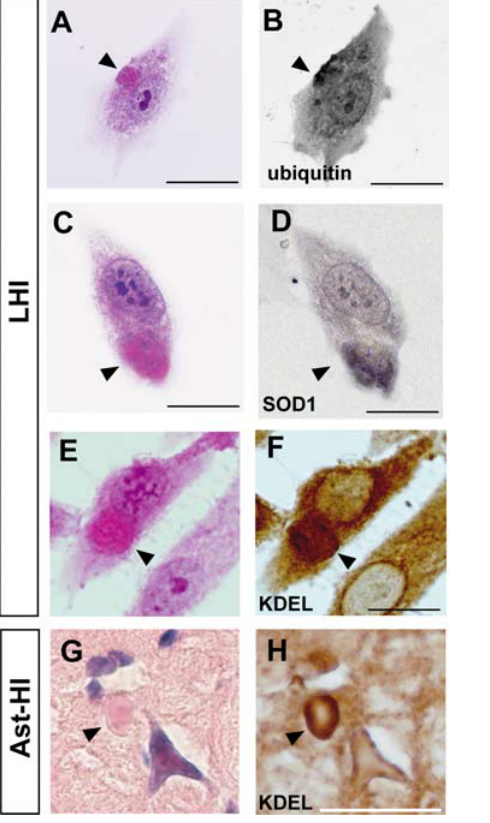
Figure 6. Positive immunoreactive against ubiquitin, SOD1 and KDEL of LHIs. ( A–D ) LHIs show immunoreactive against ubiquitin and SOD1. Eosinophilic LHIs in SK-N-SH cells (arrowheads in A and C ) induced by tunicamycin were immunostained for ubiquitin ( B ) and SOD1 ( D ) after de-colorization. ( E–H ) KDEL immunoreactive in both LHI and Ast-HI. Eosinophilic LHI in SK-N-SH cells (arrowhead in E ) and Ast-HI in spinal cord of L84V SOD1 mouse (arrowhead in G ) were immunostained against anti-KDEL antibody after de-colorization ( F, H ). Scale bar=20 m m